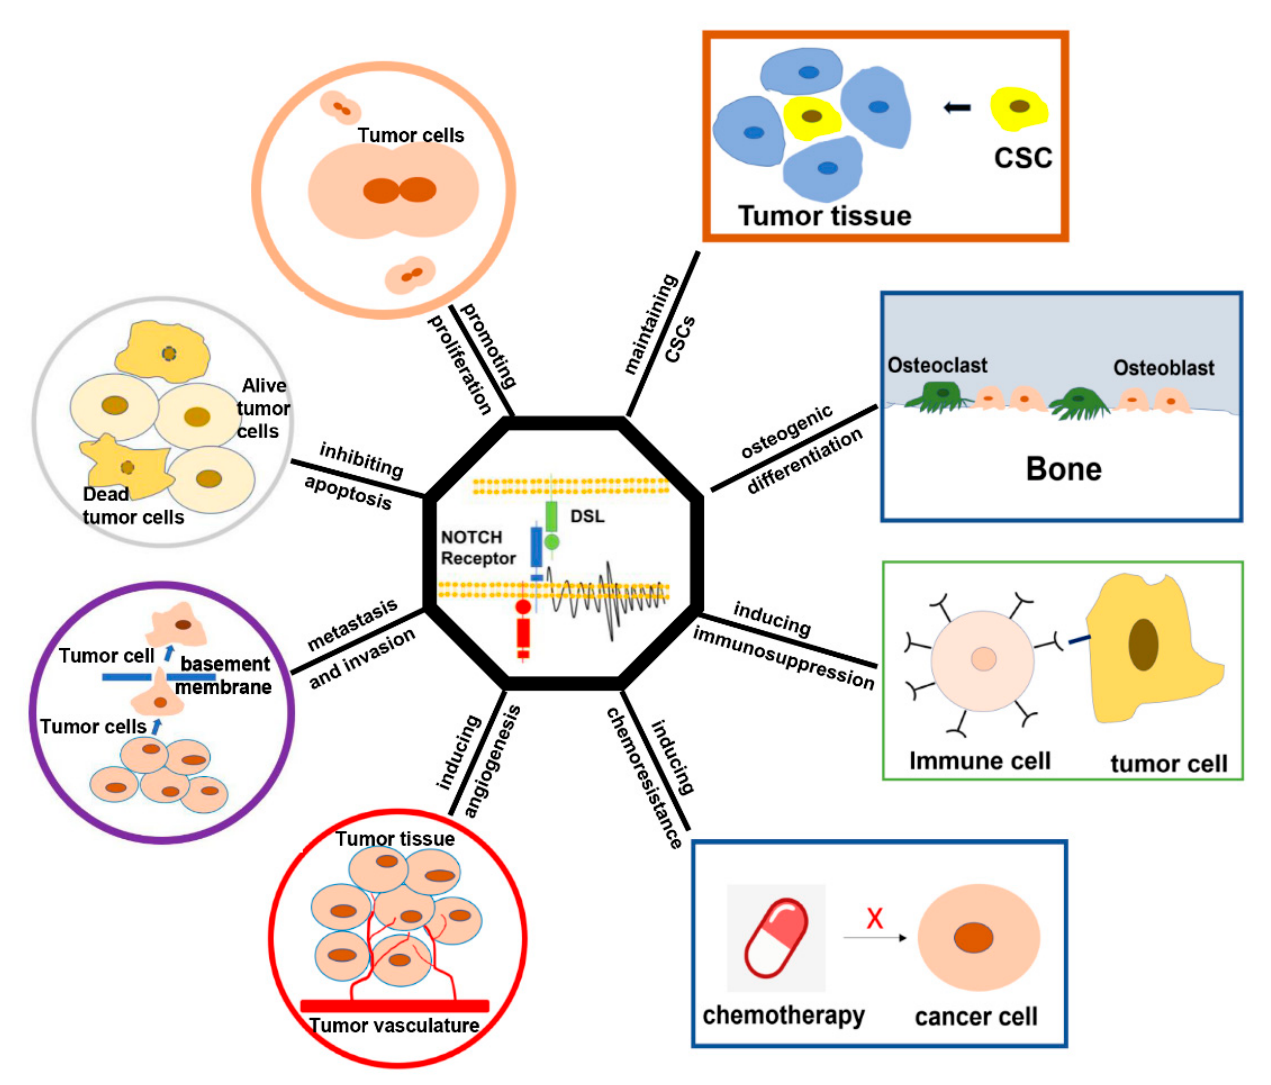
Figure 2. Effect of the NOTCH signaling pathway on osteosarcoma. Table 3. Biological effect of the NOTCH signaling pathway on osteosarcoma.